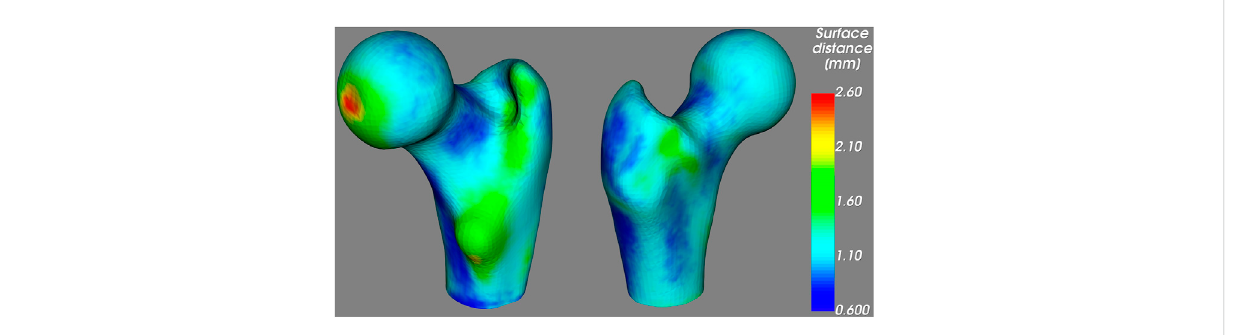
FIGURE 6 Average unsigned distance between the proximal femur surfaces obtained from the CT and the 3D DXA images, mapped on the standard femur.